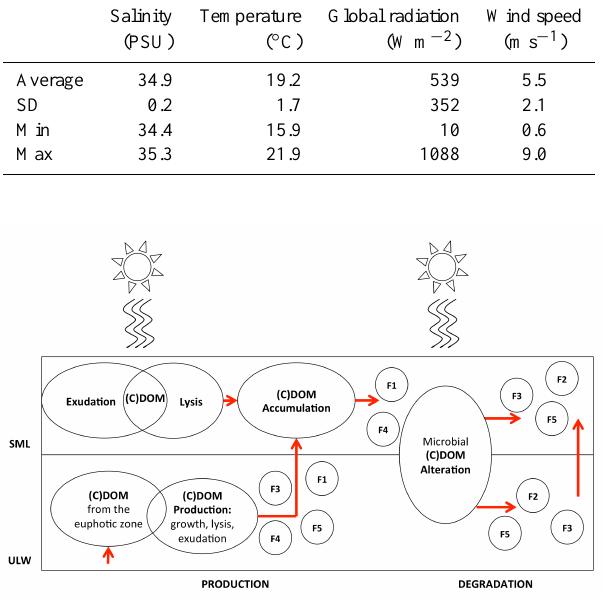
Figure 1. Conceptual model of the sources and modifications of optically active DOM in the SML and underlying seawater in the upwelling region off the coast of Peru during the SOPRAN M91